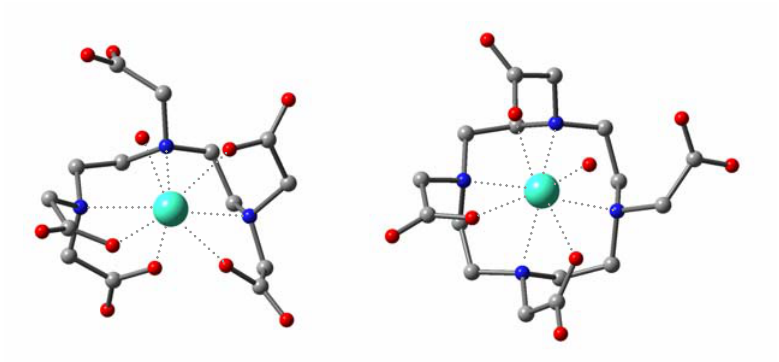
Figure 5. Optimized transition structures for the first step of the dissociation process of the Gd(III)-dtpa (left) and Gd(III)-dota (right) complexes.